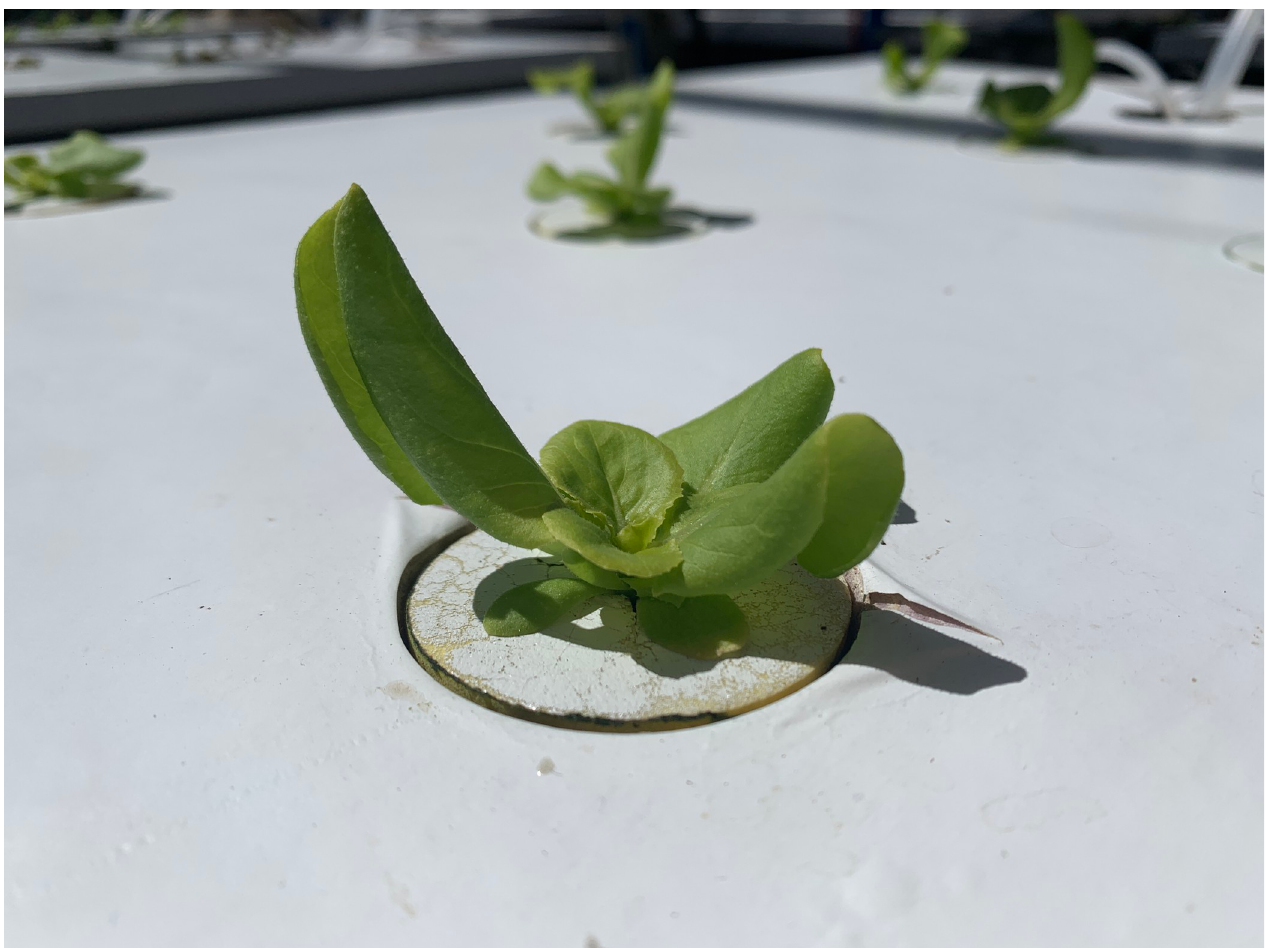
Fig 9. Lettuce seedling in neoprene collar placed in rigid cover above nutrient solution surface about 7 days after